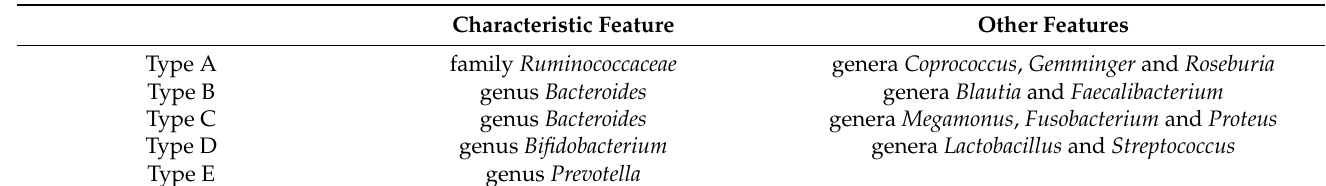
Table 3. Summary of taxonomic features characteristically rich in gut microbiota of each PAM- identified type.